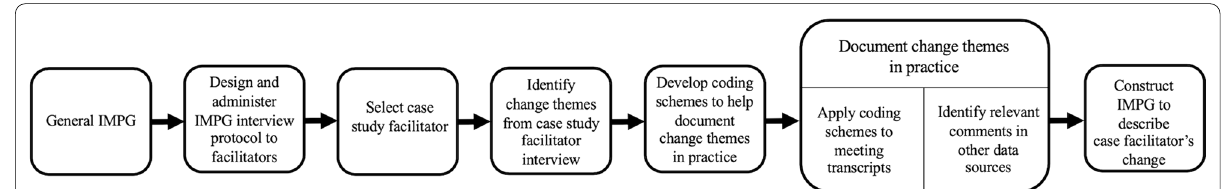
Fig. 3 An overview of the methodological process of the